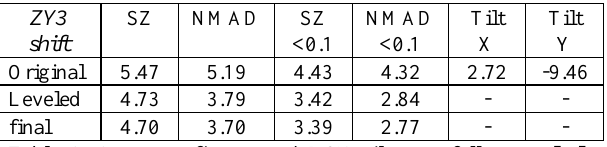
Table 9: Accuracy figures and DSM-tilt over full range [m], ZY3 against reference DSM; orientation by bias correction by shift; <0.1 = for slope below 0.1